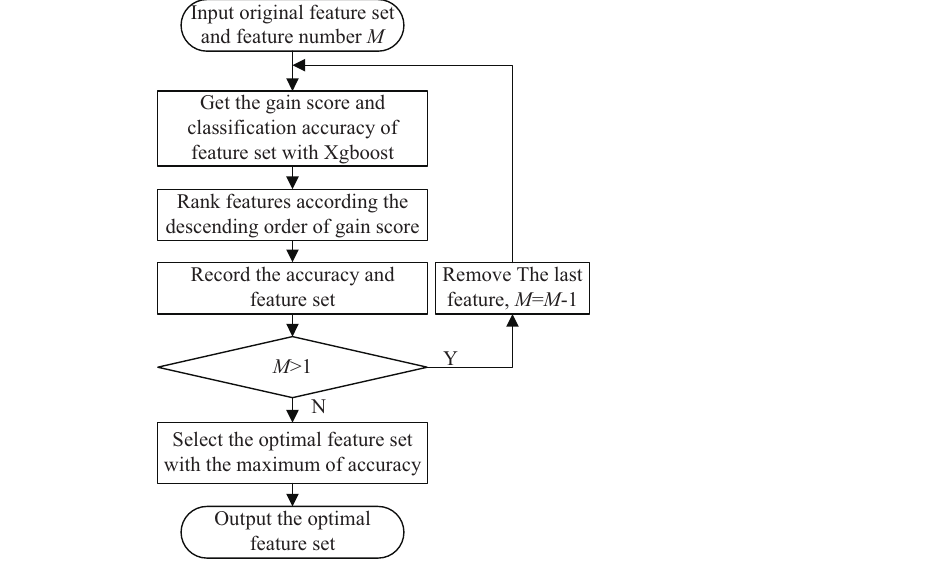
Figure 4. The program flow chart of feature selection in the XGBoost